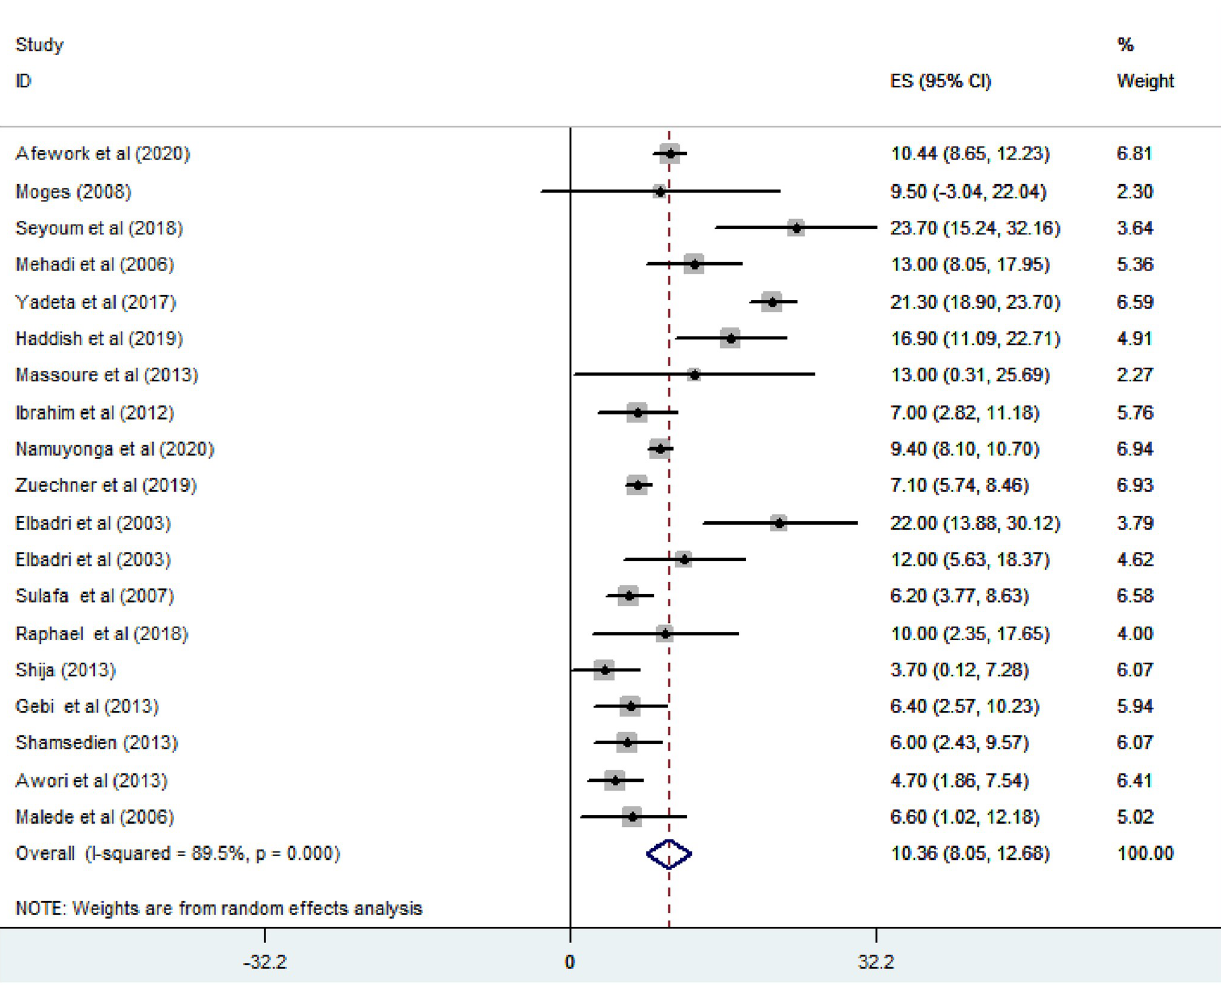
Fig 7. Forest plot showing the pooled prevalence of atrial septal defect among congenital heart defect patients in East Africa, from January 2000-October 2020.